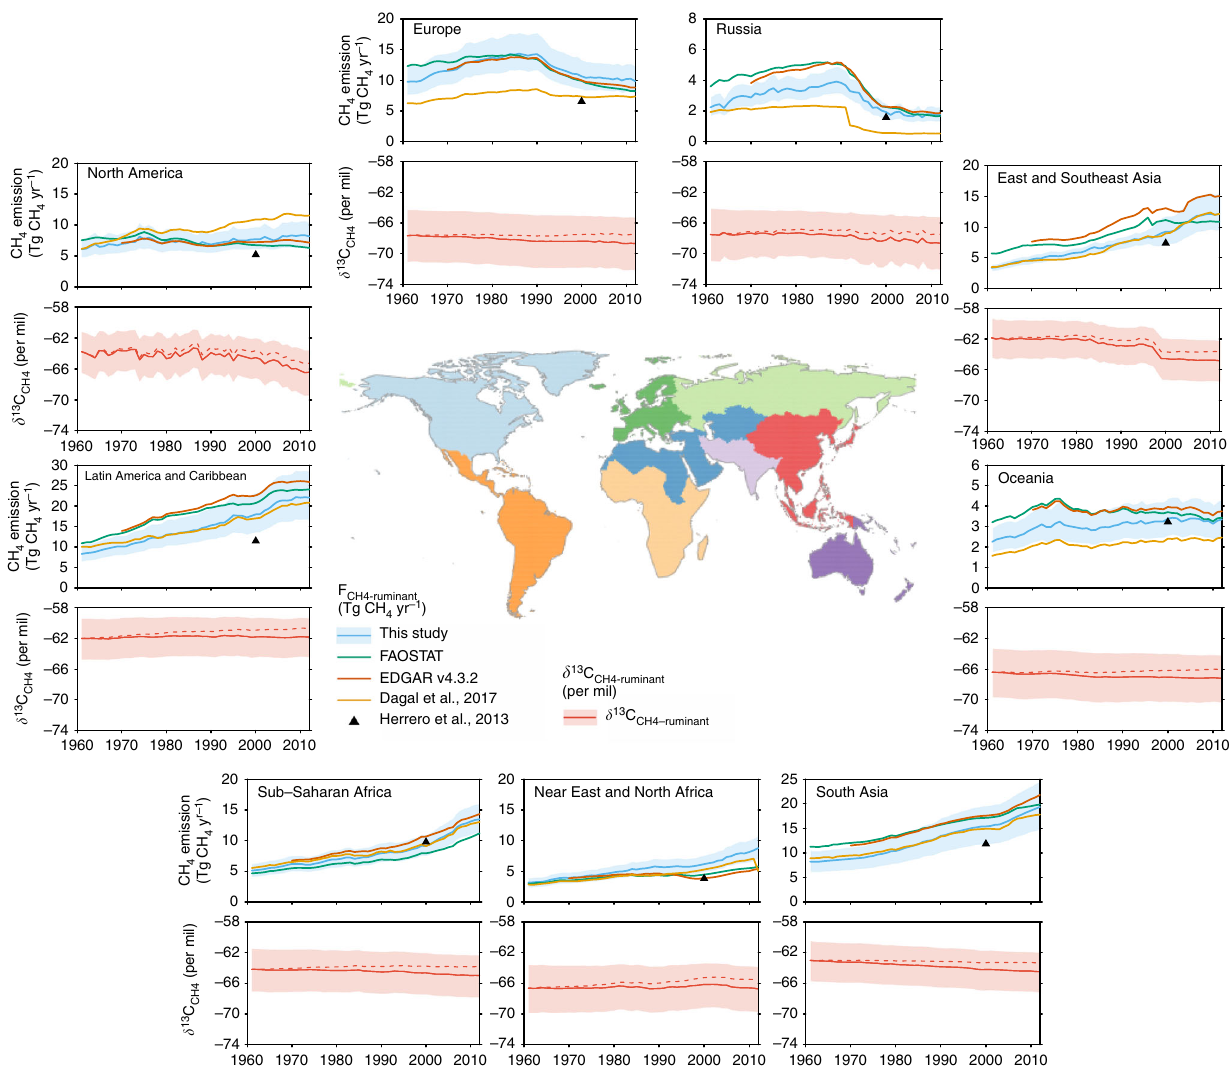
Fig. 4 The changes in the regional methane emissions from enteric fermentation of ruminants ( F CH4-ruminant ), and their weighted average isotopic signatures δ 13 C CH4-ruminant over the period of 1961 – 2012. The blue and red solid lines show the mean value of livestock emissions and their δ 13 C CH4 from this study, respectively. The blue and red shaded areas give the 95% con fi dence interval of those estimates. The red dashed lines show the δ 13 C CH4-ruminant without accounting for the decreasing δ 13 C CO2-atm trend (see Methods). Regions are classi fi ed following the de fi nition of the FAO Global Livestock Environmental Assessment Model 66 . Western and eastern Europe are combined as Europe. The vertical-scale of the regional methane emissions has been adjusted so that the changes can be easily